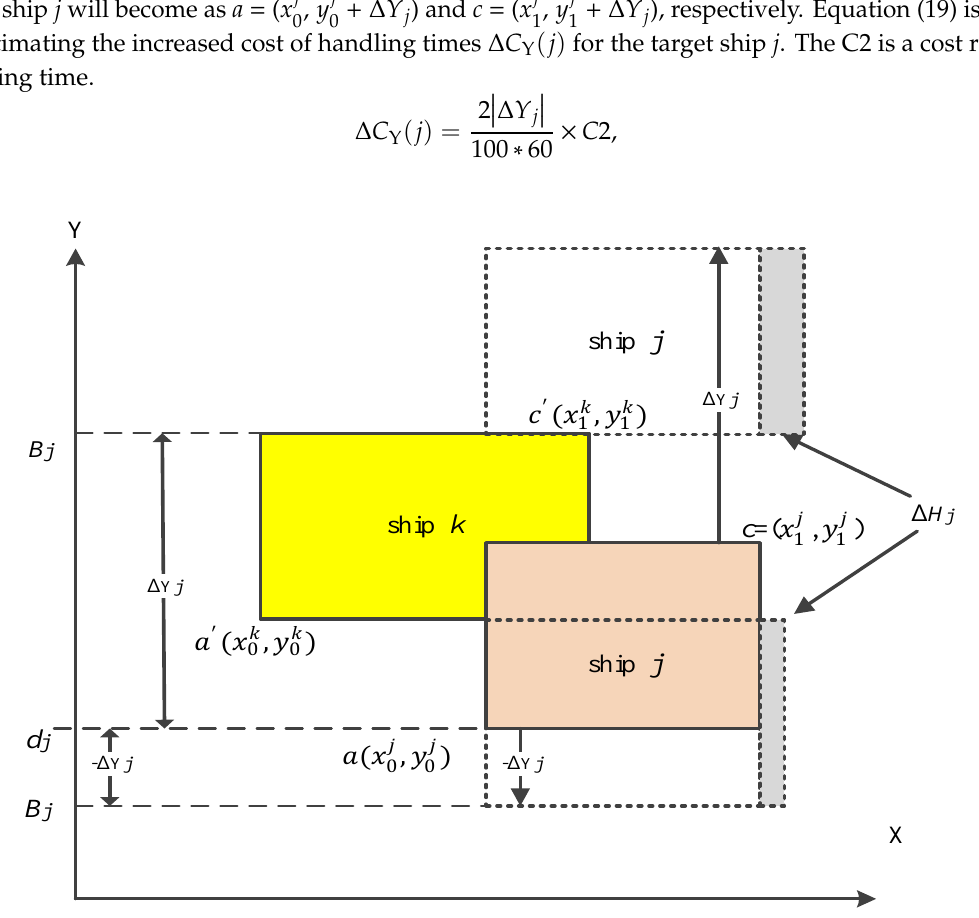
∆𝑋 𝑗 Figure 9. Increasing the target ship j ’s waiting time when moving towards +X. 